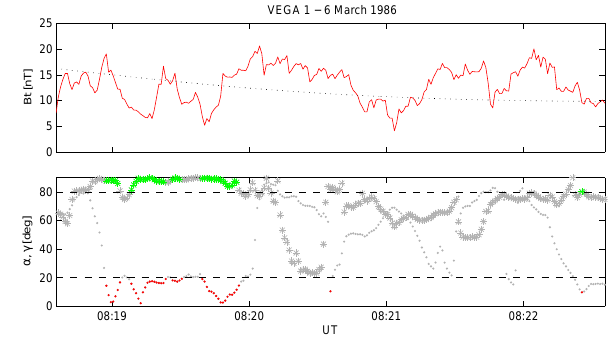
Fig.7. ExampleofanMMintervalintheVEGA1data,insimilarformatasFig.4. Figure 7. Example of an MM interval in the VEGA 1 data, in simi- lar format as Fig. 4.